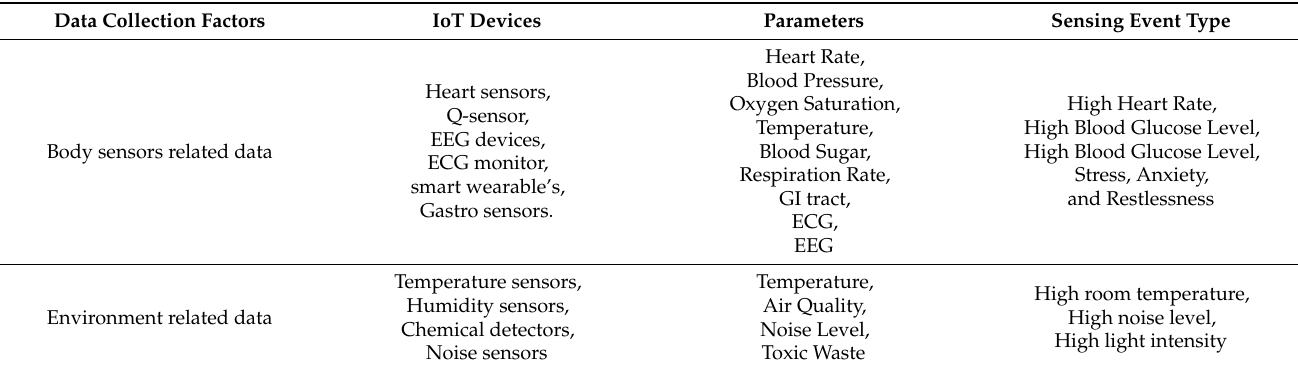
Table 2. Patient healthcare